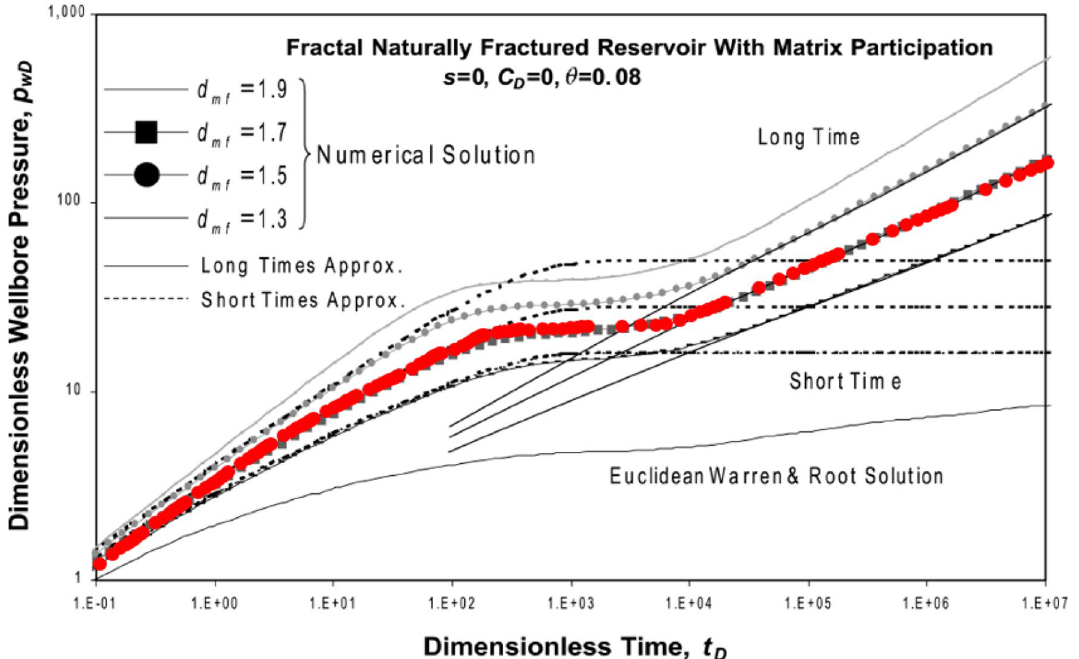
Fig. 28 The type curve matching of the results obtained by the proposed models and the results obtained by Flamenco-Lopez and Camacho- Velazquez (2003)